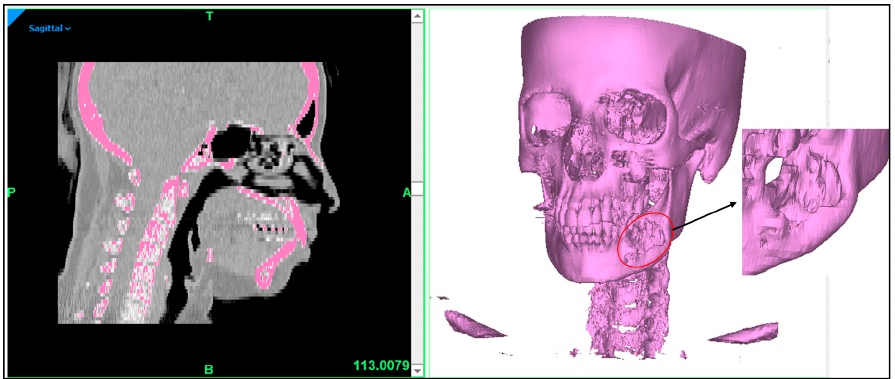
Figure 2. Patient anatomical model revealing the tumor mass and the resultant bone destruction on the left side of the mandible.